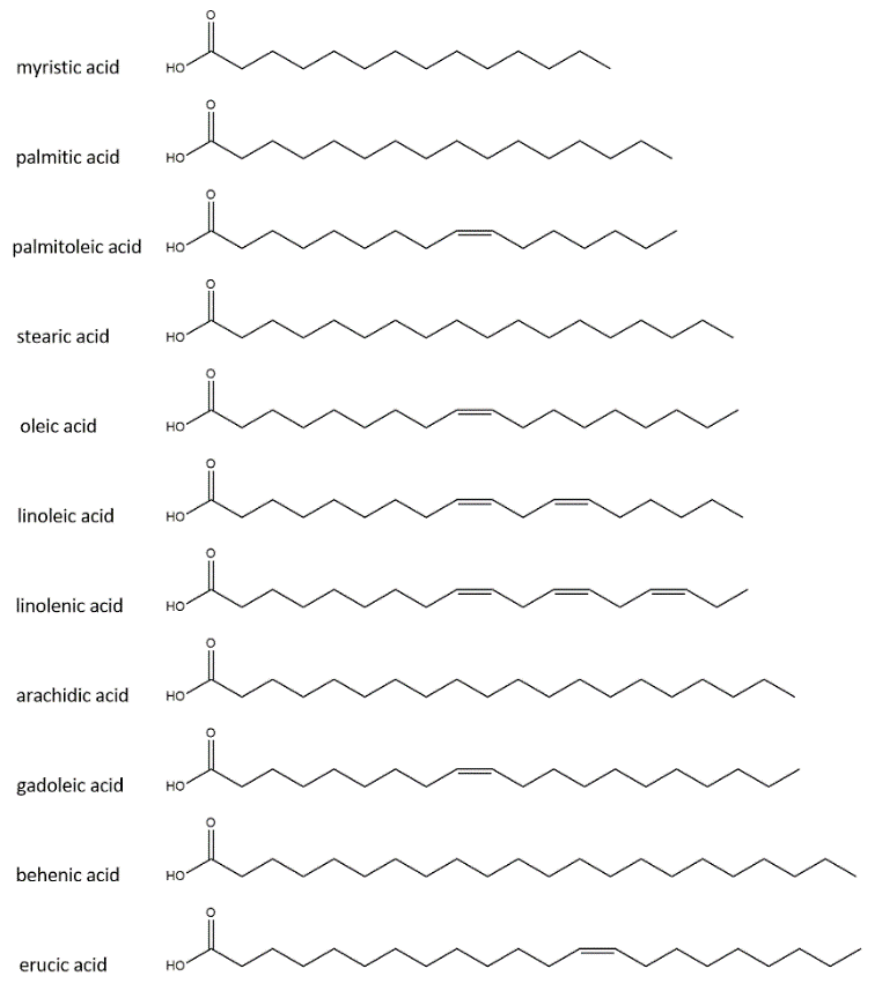
Figure 1. Chemical structure of fatty acids presents in the oils used.